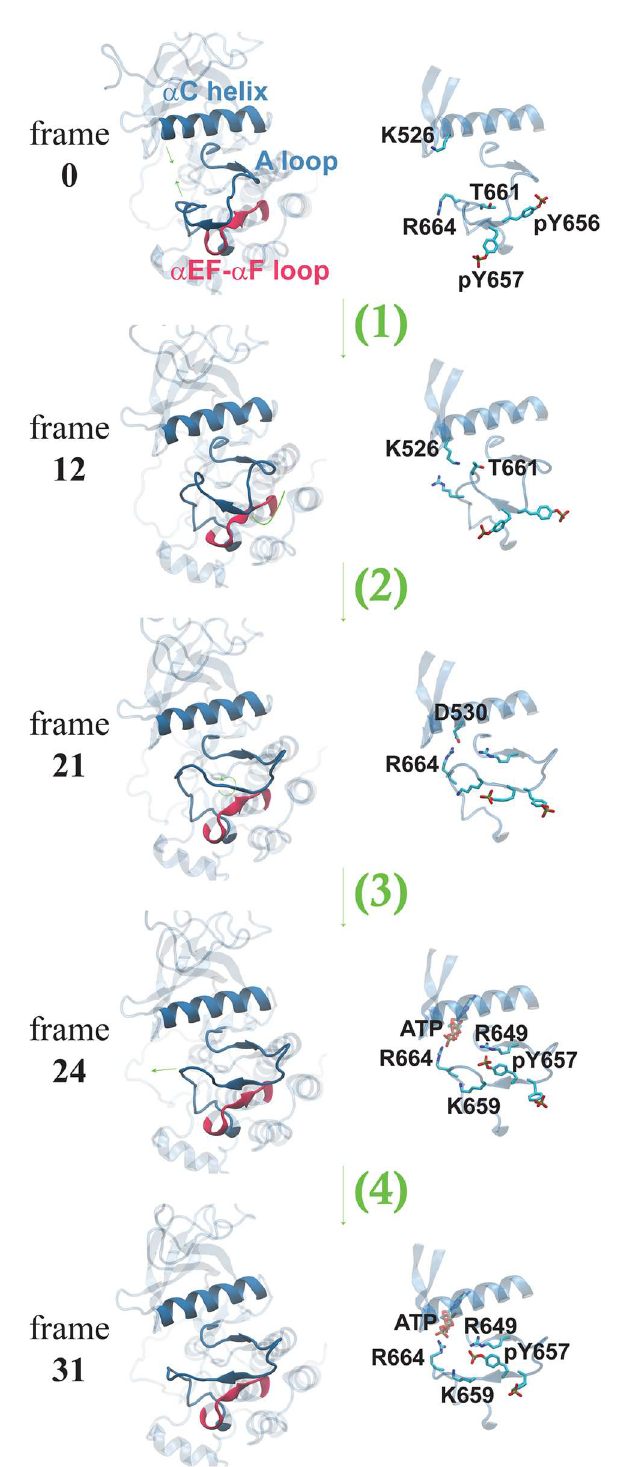
Fig 1. Minimum free energy path (MFEP) determined by the string method in collective variables. The left column shows four changesto the backbonethat occur in the pathway: (1) motion of residues660–663 and α C helix toward one another; (2) slidingof α EF- α Floop along activationloop; (3) rotation of the backbone of the activationloop to form a β -strand; (4) outwardmotion of residues660 through 663. The right column shows the sidechainmotions that accompanythese backbonemotions, includingmotions of Arg664 toward ATP, as describedin the text.